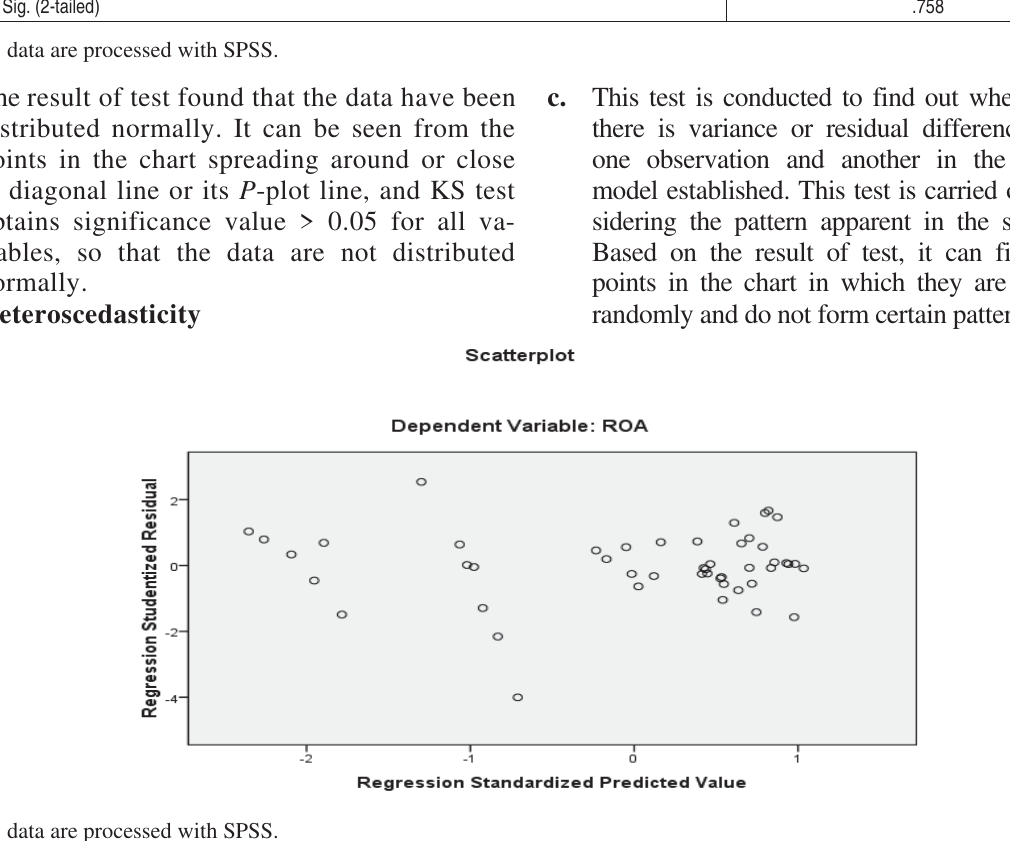
Fig. 2. Heteroscedasticity